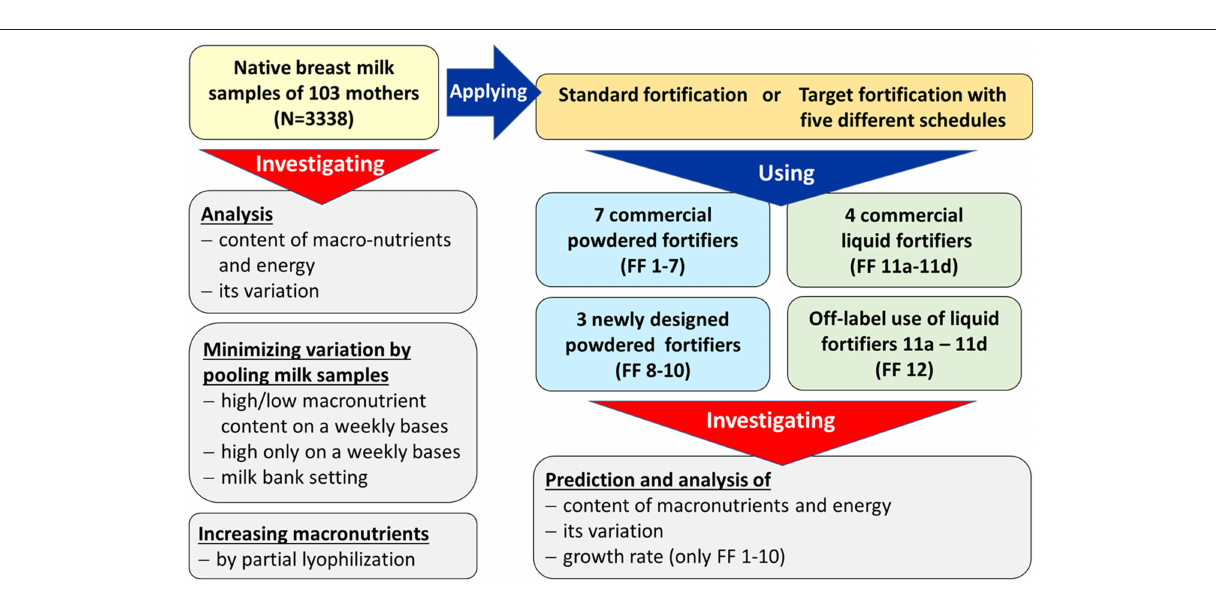
FIGURE 2 | Workflow of experiments (FF,